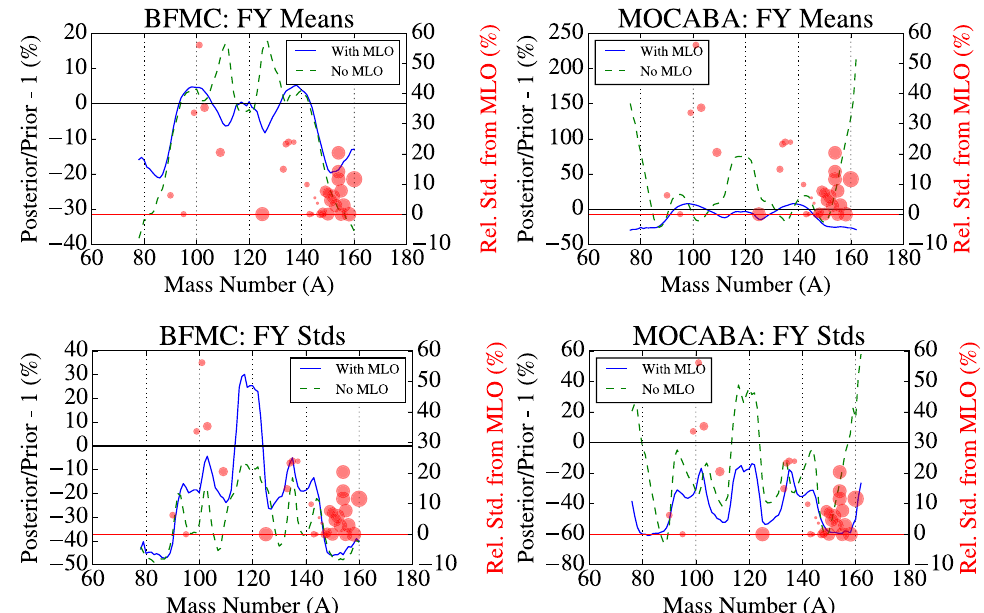
Fig. 14. The left y-scale shows Relative differences between the prior and posterior means and the relative standard deviations (relative to their perspective means) FYs of Pu-239 calculated when MLO was and was not used. The right y-scale (in red) shows the added relative standard deviation to the PIE data by MLO, with the size of red dot being proportional to the skewness of the calculated value’s